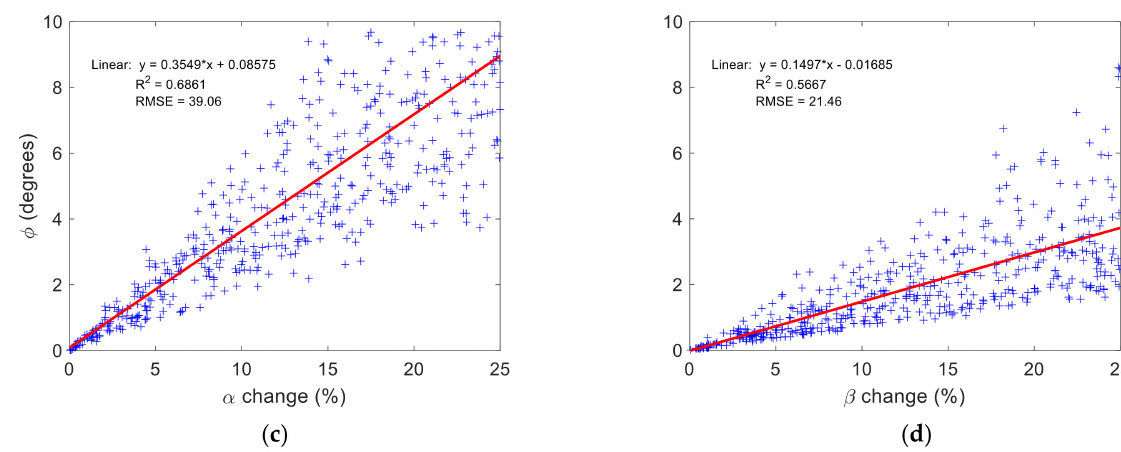
Figure 4. Illustration of the sensitivity of time fractional Bloch model to changes in each of the model parameters under the assumption ∆ f = 0. On the x -axis, the change in the parameter is provided, plotted against the actual change in the signal and measured as the angle between the two vectors (i.e., dot product, as used for matching the simulated signal with acquired MRF signal). Each data point on each plot has been generated by randomly choosing parameter values from the appropriate parameter ranges. Each figure was repeated for 500 random instances and percentage error change in the parameter was also chosen random in the range (0, 25%). Shown are sensitivities to changes in ( a ) T 1 , ( b ) T ∗ For each plot, a linear regression was performed and R2 and root-mean-squared error (RMSE) are provided.